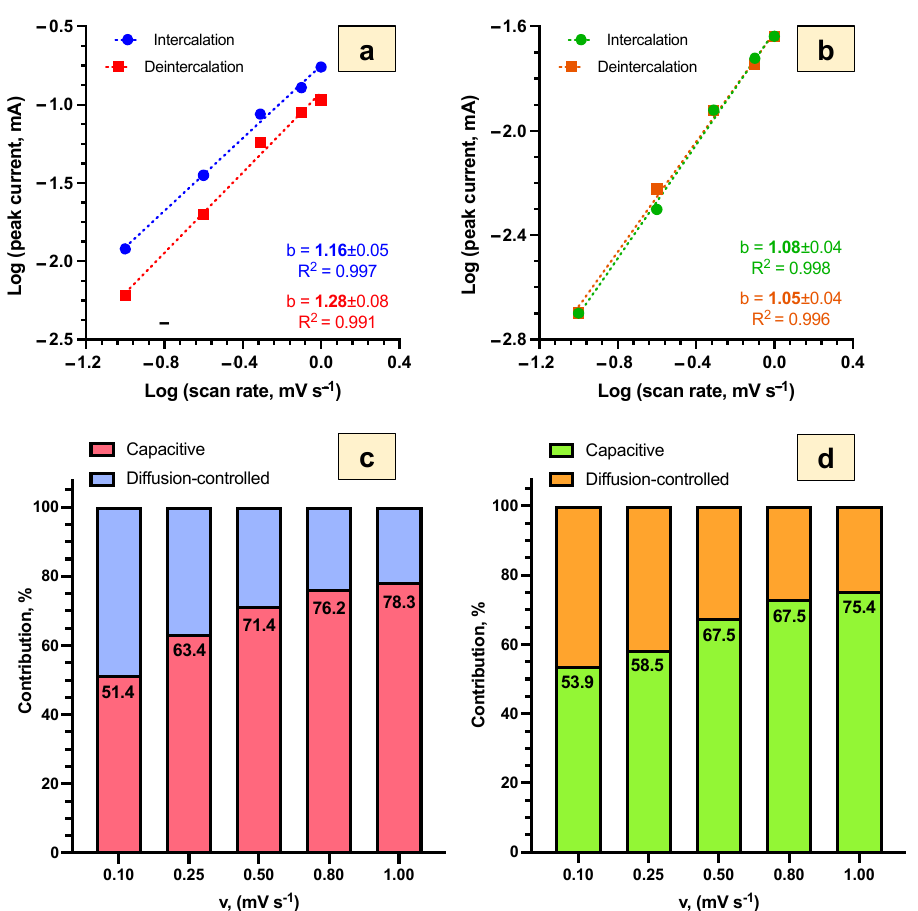
Figure 7. Investigation of the dominant stage and contribution of capacitive and diffusion-based processes for Li + intercalation/deintercalation in Bi 2 Se 3 thin films in 5 M LiNO 3 : ( a )—log-scale plots for the SEI layer ( − 1.0 V ÷ 1.3 V vs. Ag/AgCl), ( b )—log-scale plots for the Bi 2 O 3 layer ( − 1.0 V ÷ 0.5 V vs. Ag/AgCl), ( c )—the contribution of capacitive and diffusion-controlled processes for the SEI layer ( − 1.0 V ÷ 1.3 V vs. Ag/AgCl), ( d )—the contribution of capacitive and diffusion-controlled processes for the Bi 2 O 3 layer ( − 1.0 V ÷ 0.5 V vs.